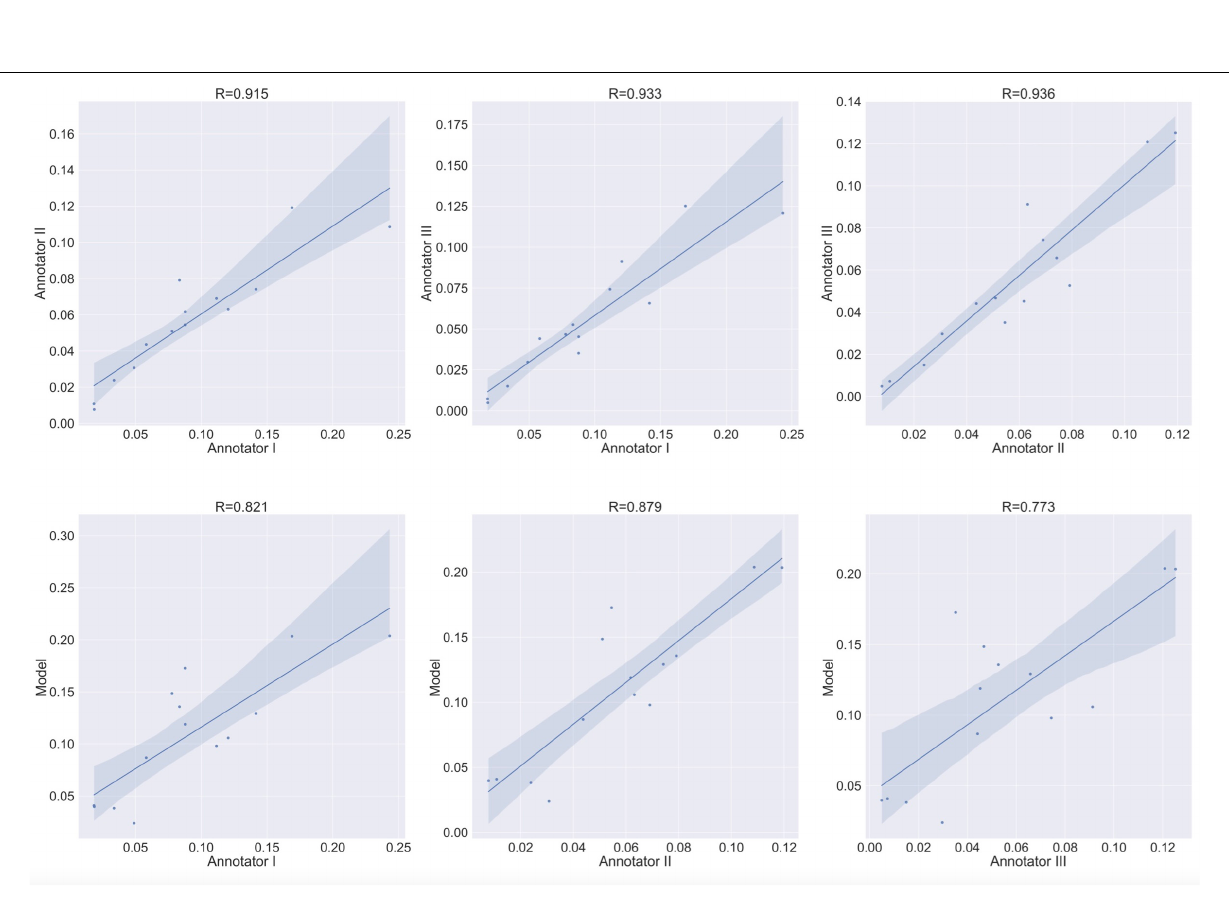
FIGURE 9 | Agreement level on the cell counting task of Type 1 osteoclasts. Shaded area represents the variation boundaries. Upper row: correlation between the three annotators for the cell counting task performed on the same set of culture images. Bottom row: correlation between each annotator and the model’s prediction for the cell counting